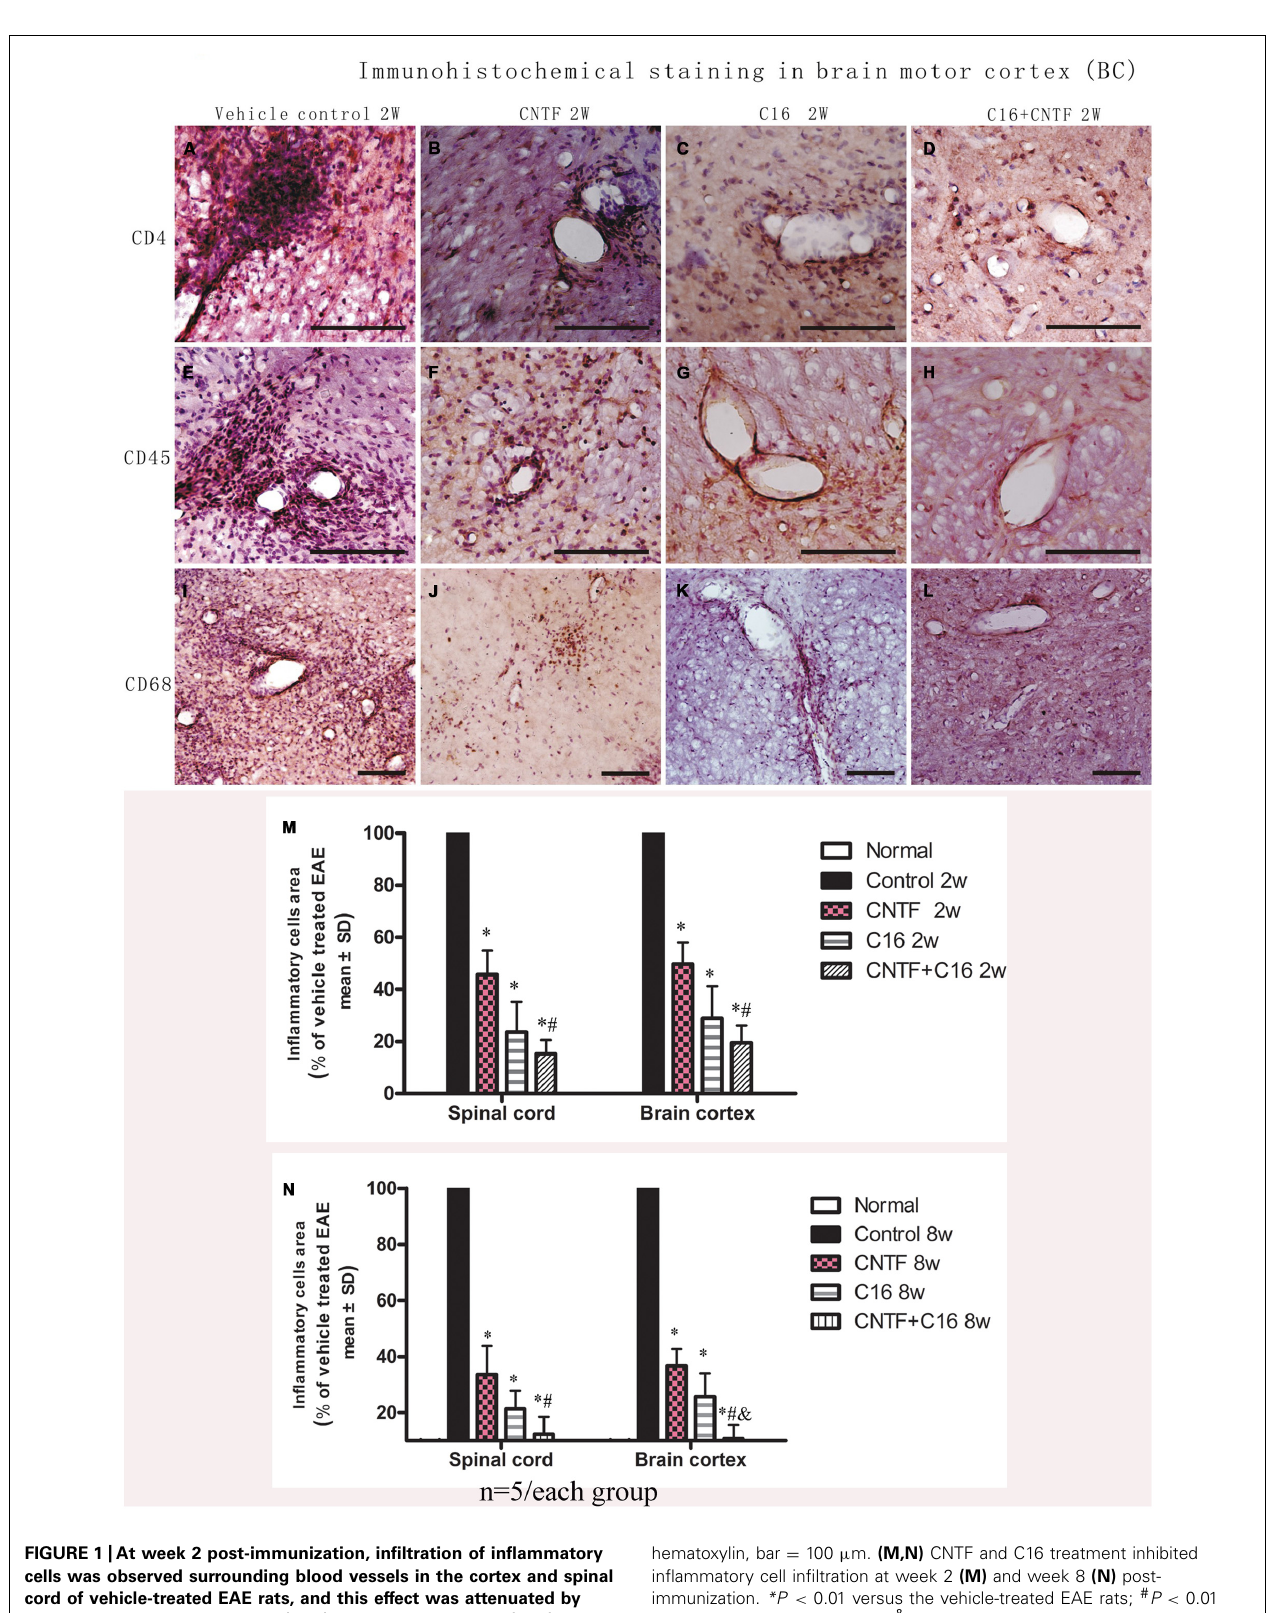
hematoxylin, bar = 100 μ m. (M,N) CNTF and C16 treatment inhibited inflammatory cell infiltration at week 2 (M) and week 8 (N) post- immunization. *P < 0.01 versus the vehicle-treated EAE rats; # P < 0.01 versus CNTF-treated EAE rats; & P < 0.01 versus C16-treated EAE